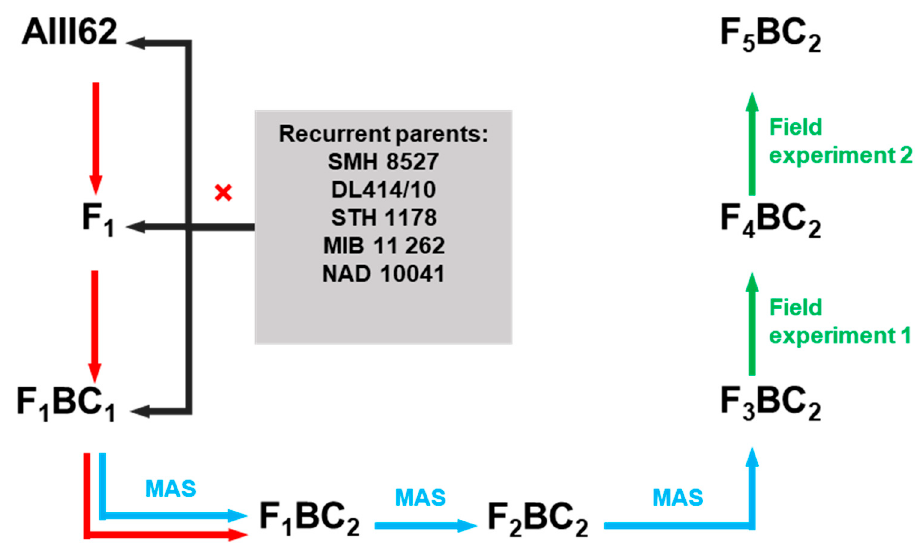
Figure 7. Scheme for marker-assisted backcross selection to introduce Fhb1 resistance gene into winter wheat. Red arrows indicate crosses, blue arrows indicate MAS (marker-assisted selection), green arrows indicate field experiments.